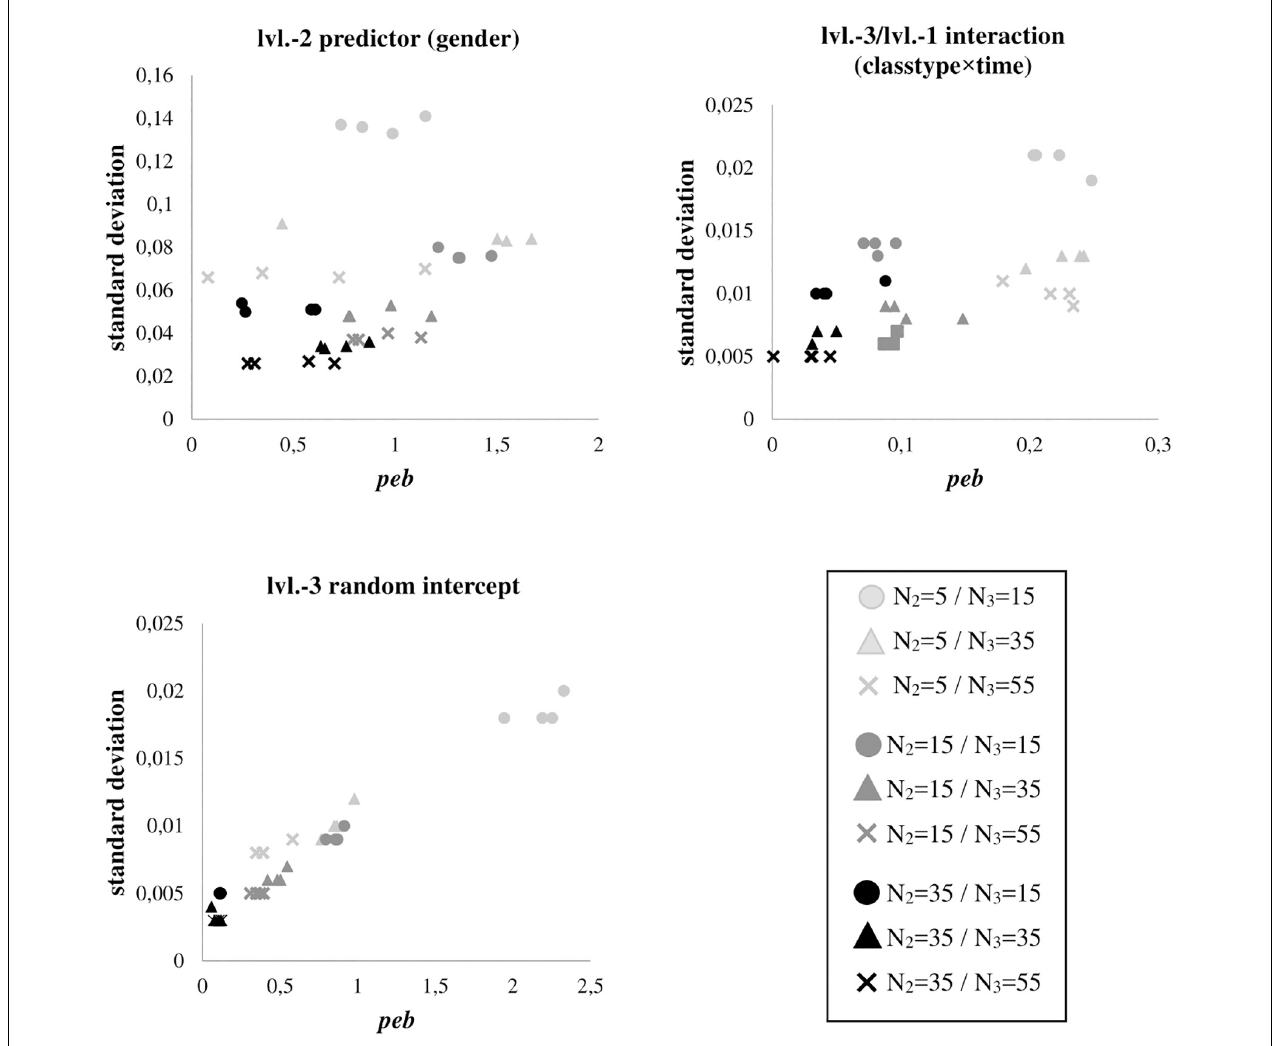
FIGURE 1 | Parameter estimation bias ( peb ) for level-2 predictor gender, cross-level interaction classtype × time, and level-3 random intercept variance, in relation to the standard deviation of their estimated parameter values over 1000 simulation runs for each sample size condition. Shades differentiate between numbers of students per class (N 2 ), shapes differentiate between numbers of classrooms per sample (N 3 ). As results are very similar between samples with and without missing values, plots do not differentiate between missing value